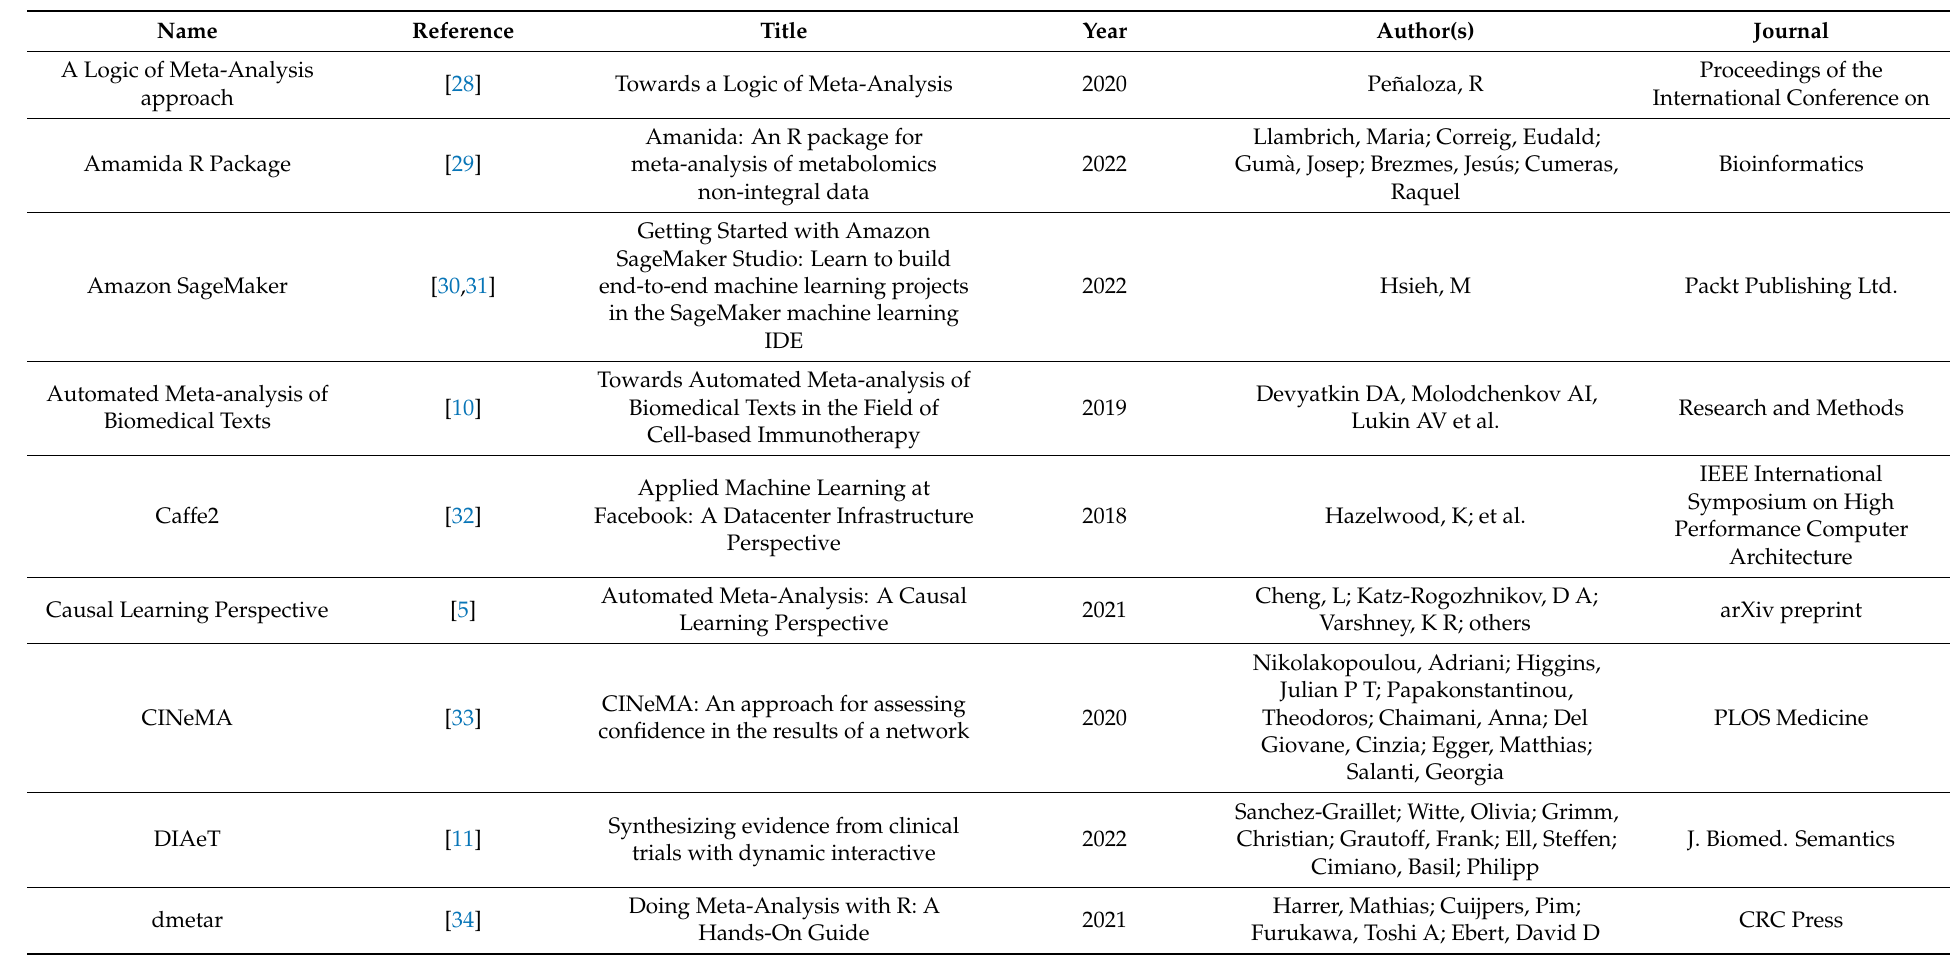
Table 1. The bibliographic elements of the included